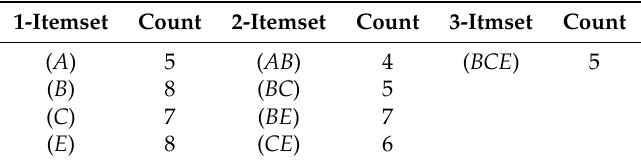
Table 2. The discovered frequent